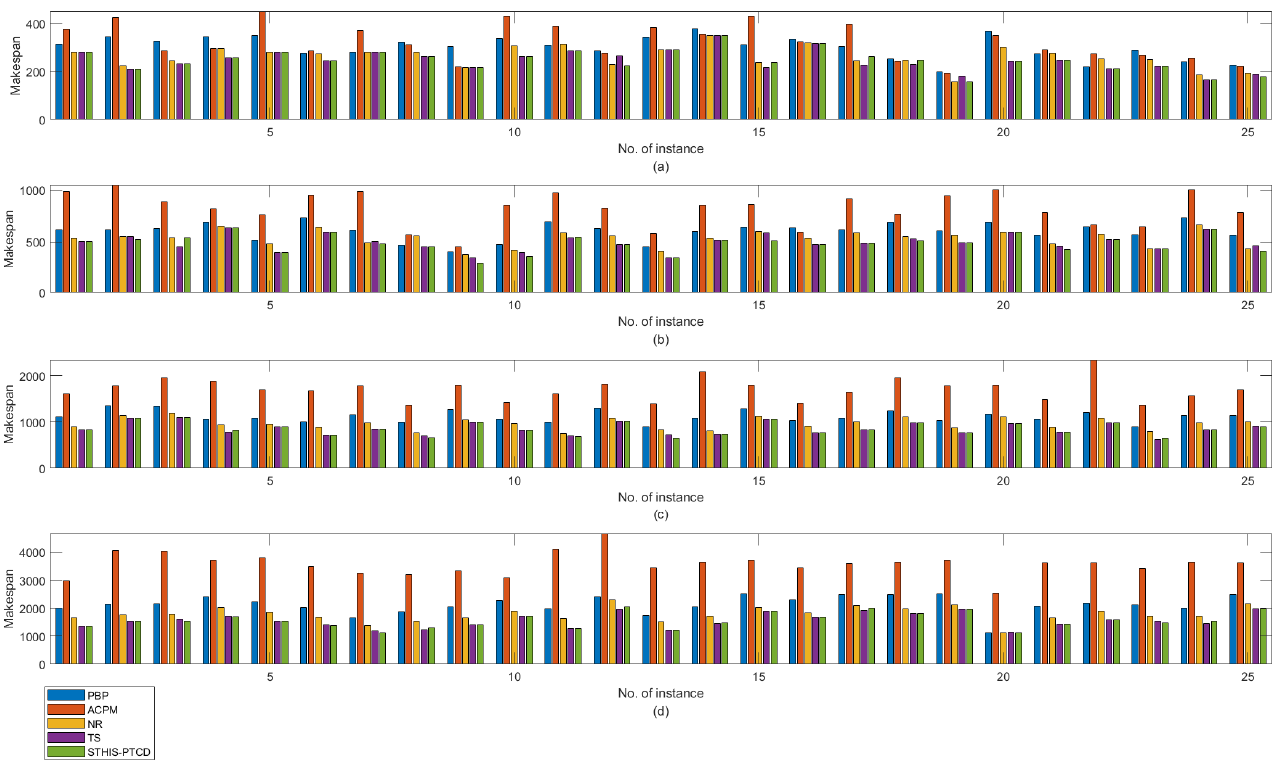
Figure 25. Results of the PBP, ACPM, NR, TS, and STHIS ‐ PTCD for 100 instances: ( a ) 20 operations; ( b ) 50 operations; ( c ) 100 operations; ( d ) 200 operations. Table 4. Experimental results of STHIS-PTCD and other